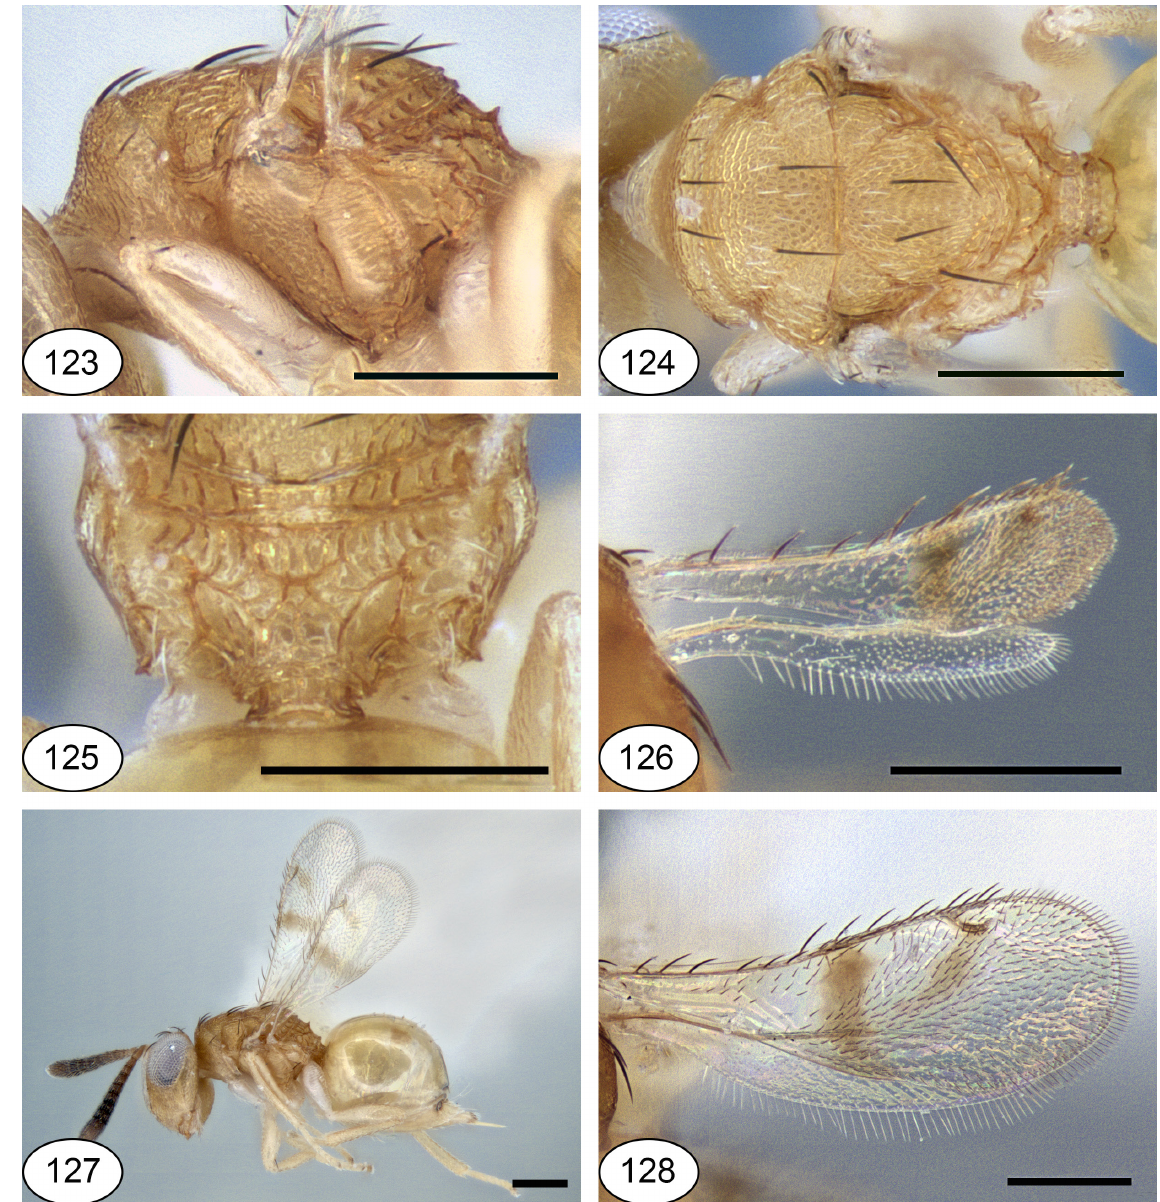
Figs 123–128. Netomocera meridionalis sp. nov. 123 . Holotype, ♀, mesosoma, lateral view. 124 . Holotype, ♀, mesosoma, dorsal view. 125 . Holotype, ♀, propodeum, dorsal view. 126 . Holotype, ♀, fore and hind wings. 127 . Paratype, ♀, habitus, lateral view. 128 . Paratype, ♀, fore and hind wings. Scale bars: 0.2